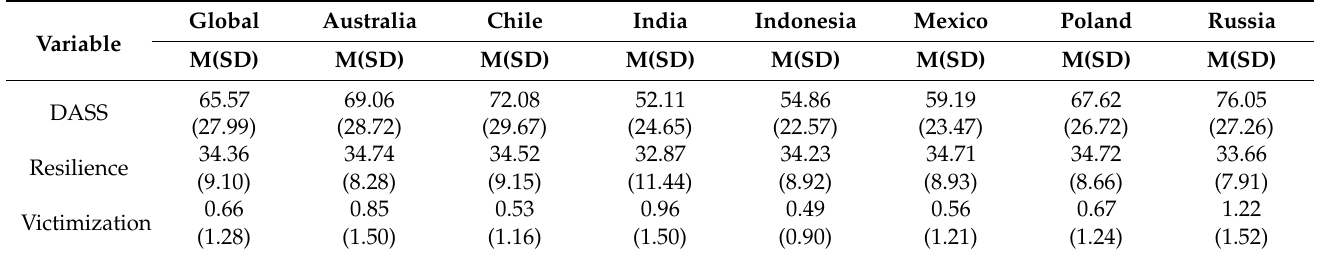
Table 3. Descriptive analysis of subjective mental health indicators, resilience, and aggression by country.